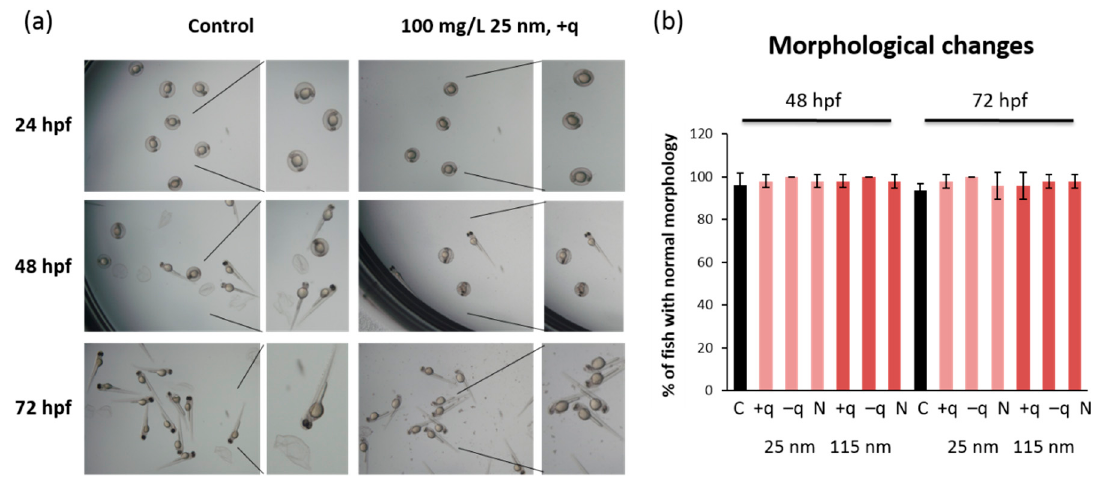
Figure 2. The effects of SiO 2 NPs on gross morphological features of zebrafish embryos. ( a ) Representative images of embryos exposed to positively charged SiO 2 NPs (25 nm) at 100 mg/L and ( b ) gross morphological changes after the exposure to 100 mg/L of 25 or 115 nm SiO 2 NPs at 48 and 72 hpf. Data are represented as mean ± SD.